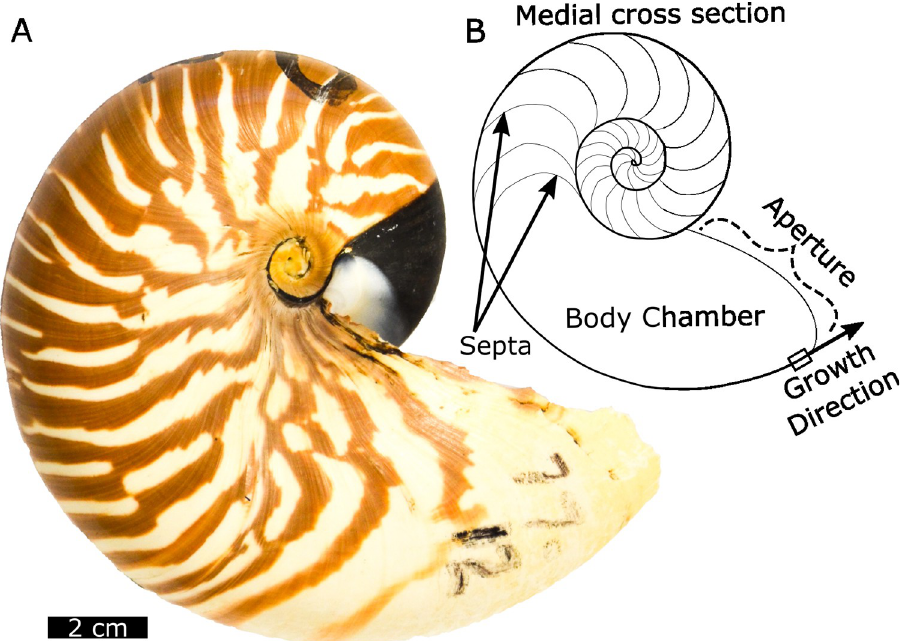
Fig 1. Overview of Nautilus m . shell (ROM 48997) with annotation of major shell structures, and growth direction. Nautilus shells grow in a spiral and septa are secreted to allow for the maintenance of neutral buoyancy during growth through the removal of liquid from the chambers [17]. Shells comprise two major structural forms of aragonite, the inner nacreous layer and outer spherulitic prismatic layer